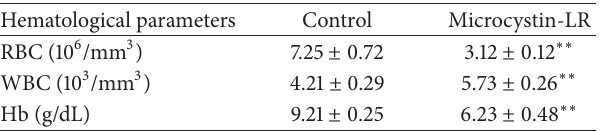
Values are mean ± SD ( 𝑛 = 3 ), ∗∗ 𝑝 < 0.01 (control versus MC-LR treated